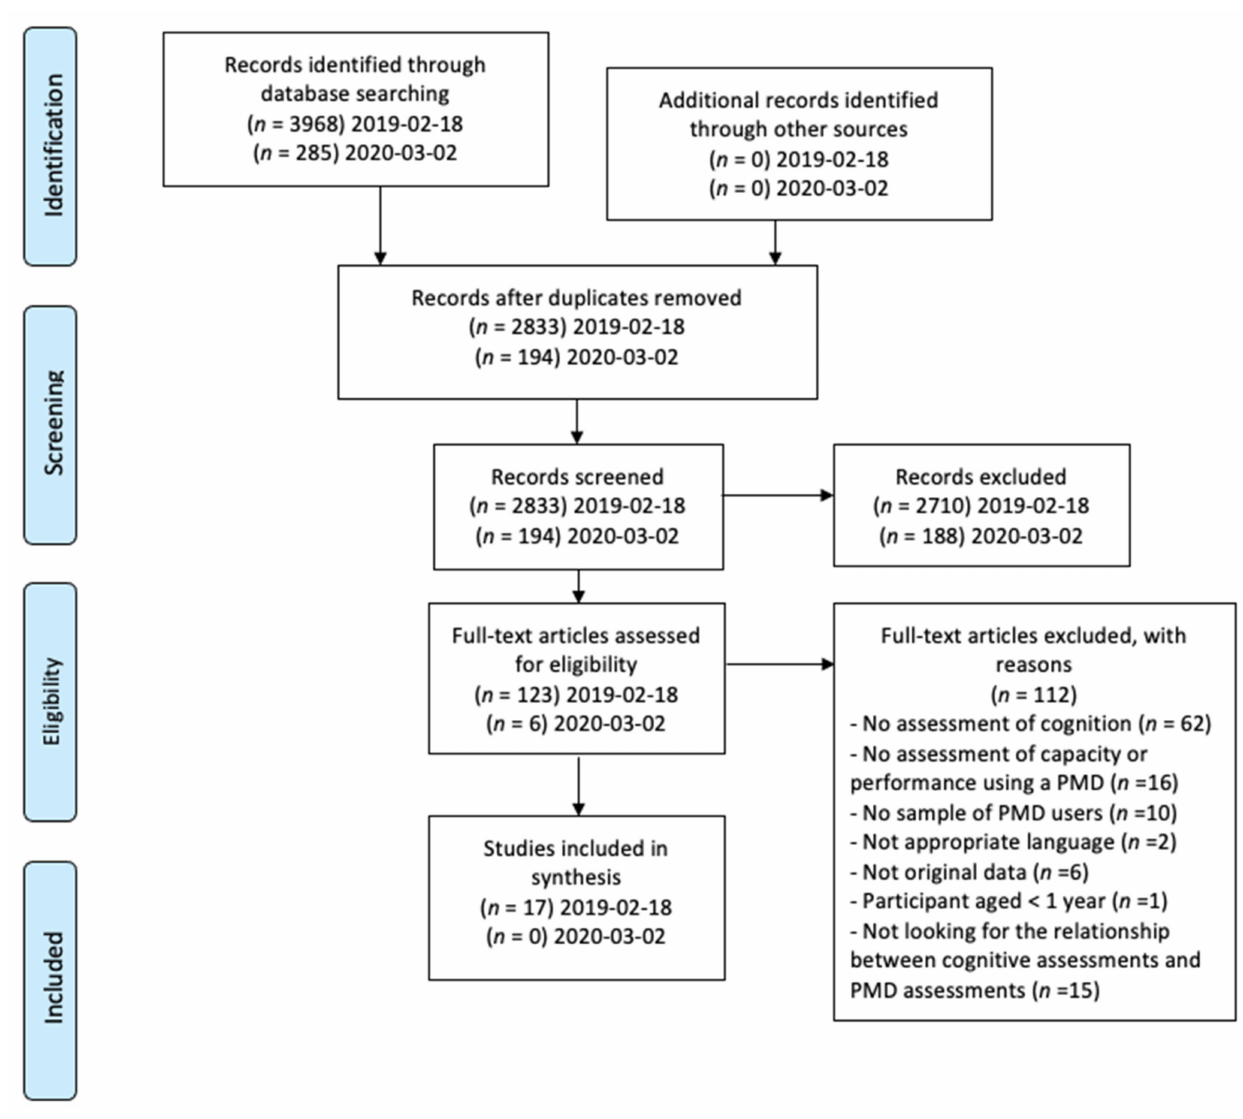
Figure 1. PRIMSA